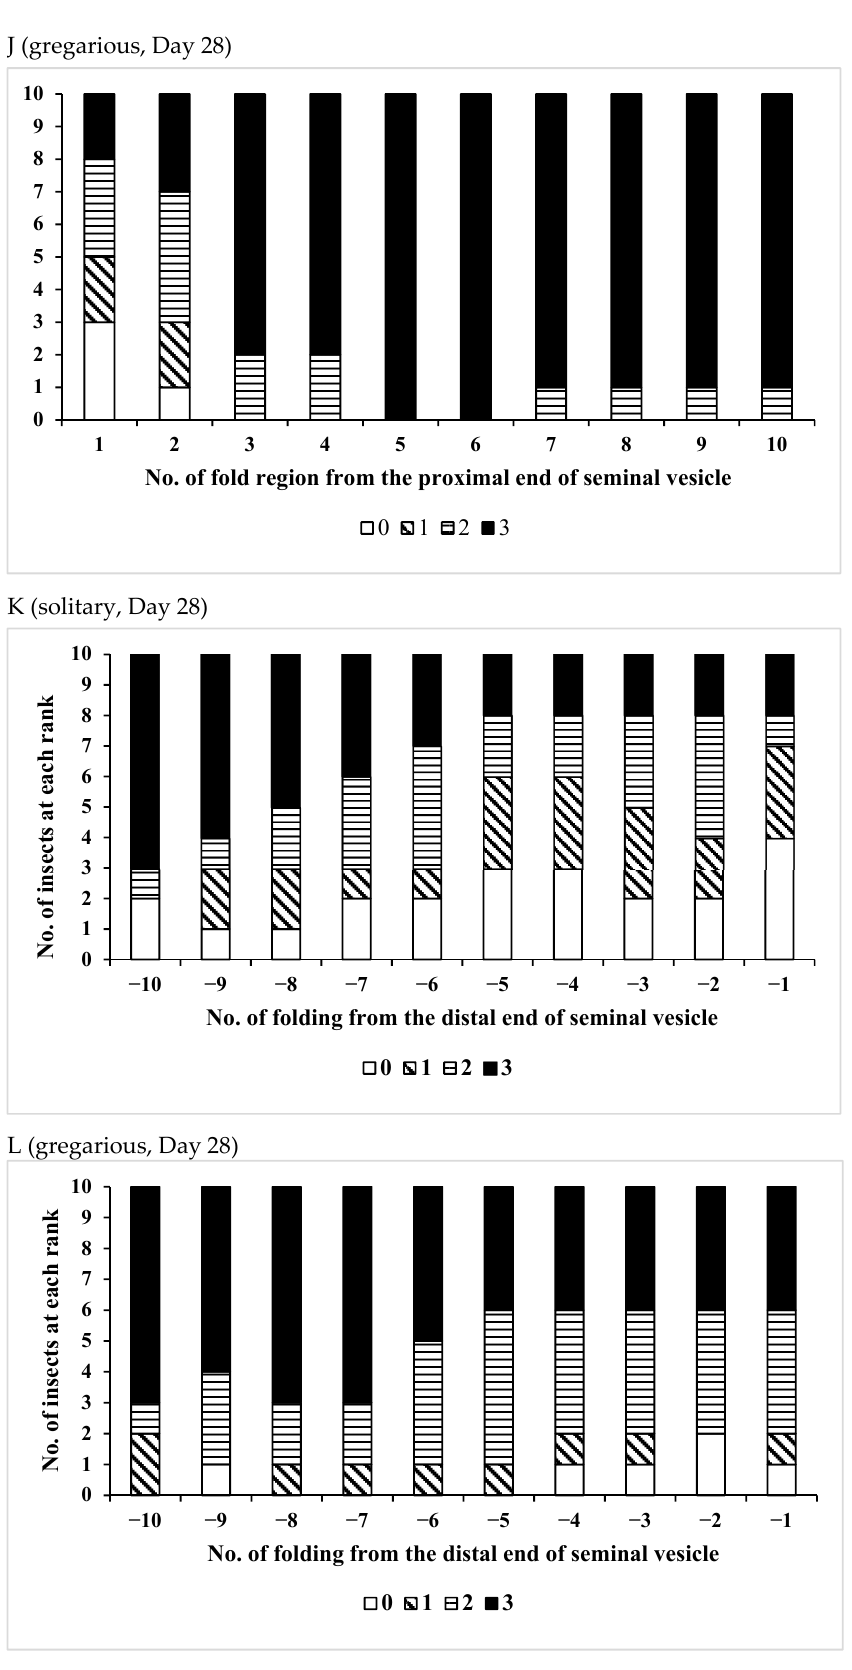
Figure 2. Distribution of sperm in the proximal part ( A , E , I ) or the distal part ( C , G , K ) of the seminal vesicle in the solitary form, and that in the proximal part ( B , F , J ) or the distal part ( D , H , L ) of the